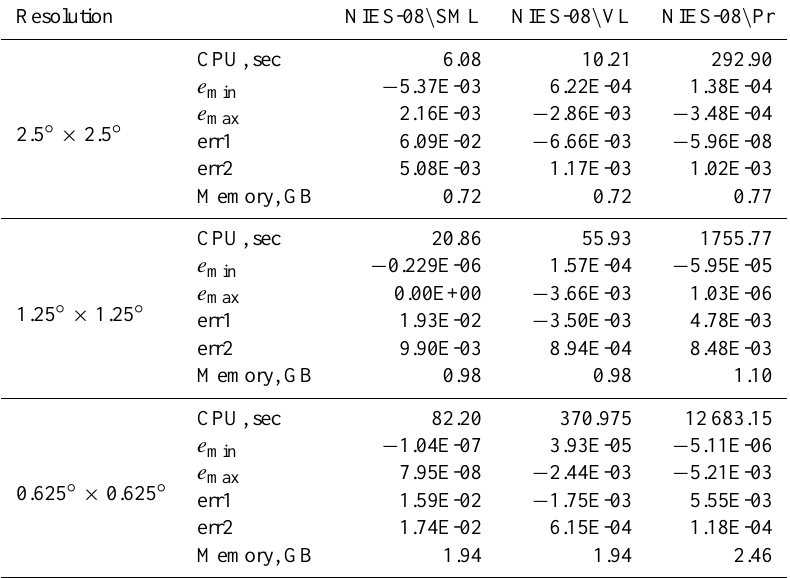
Table 1. Performance of the schemes implemented in the model NIES TM. Here, NIES-08 \ SML, NIES-08 \ VL, and NIES-08 \ Pr denote NIES TM with semi-Lagrangian, van Leer’s, and Prater’s numerical schemes, respectively. Err1 is normalized errors of the mean, err2 is variance of the field, e max is overshoot of the scheme, and e min is undershoot of the